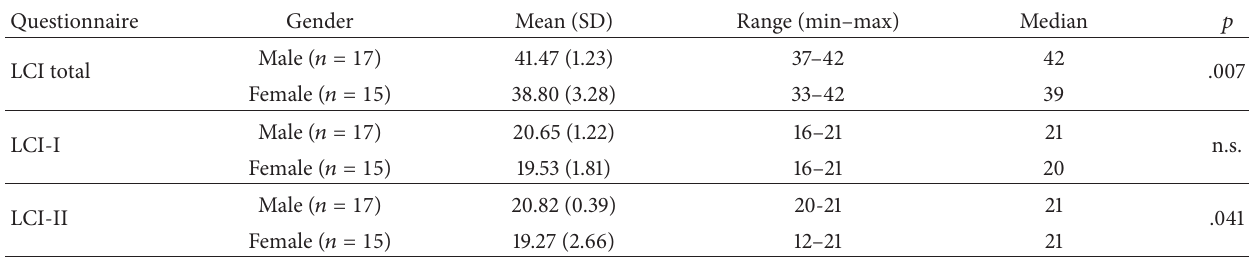
Table 2: Functional results by gender.